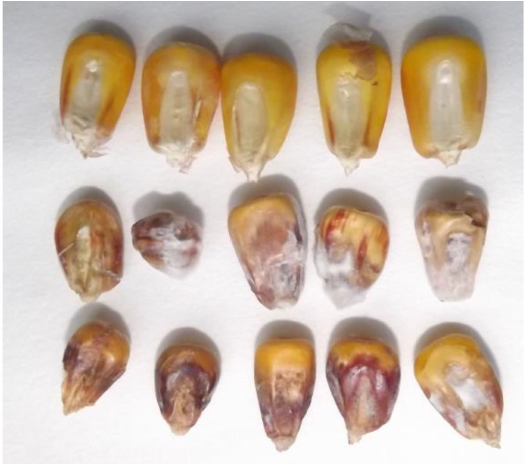
Figure 8. Maize grains from a naturally infected maize field. The upper row contains healthy grains without any visible sign of infection. The middle and lower lines contain grains whose upper part is mostly healthy, but the germ part is severely infected; in several grains, the whole surface is severely infected by Fusarium spp. (Courtesy: